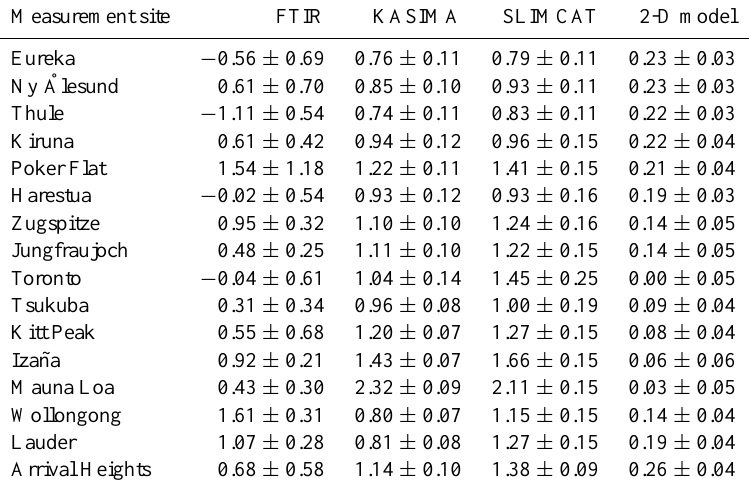
Table 6. HF trend in % per year between 2000 and 2009, calculated by fitting a linear function combined with a first (sites poleward of 70°) or third order Fourier series to the data. The error bars were determined with the bootstrap